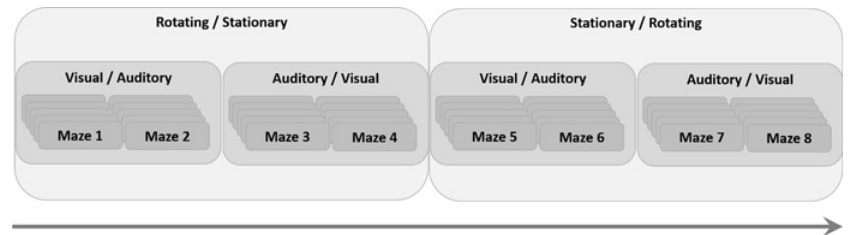
Fig 3. The protocol. A schematic representation of the experimental protocol. Participants started with either a “ stationary room ” or “ rotating room ” block of trials, within which they performed the first half of the trials. The block was further divided into auditory and visual blocks, within each one, the participants performed five consecutive repetitions of each of two